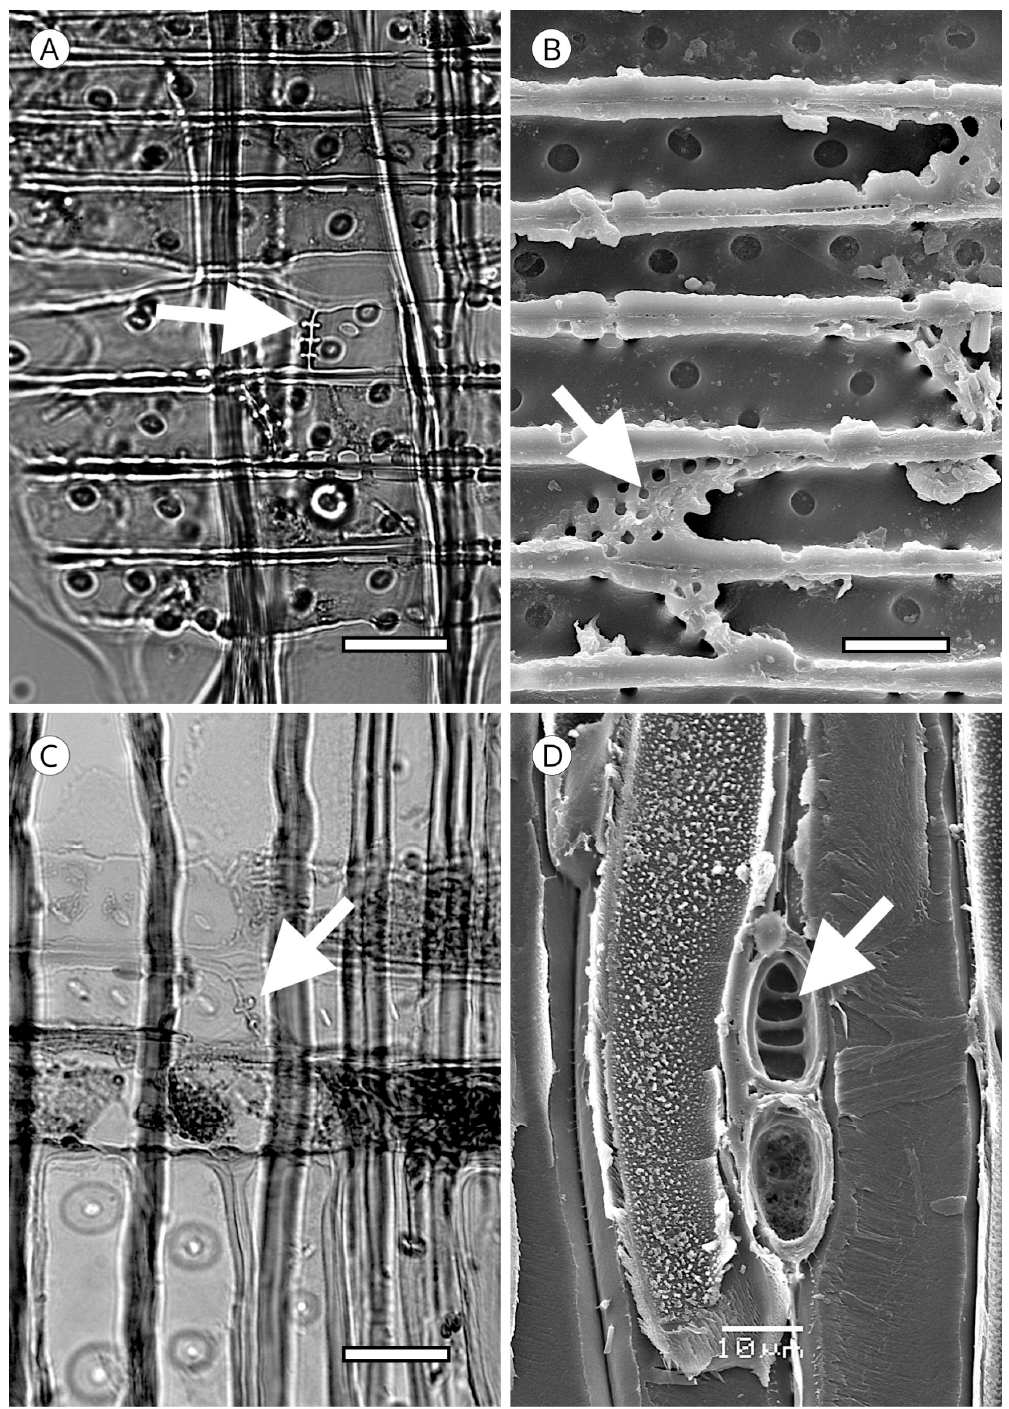
Figure 33. Nodular end walls of ray parenchyma cells. ( A ) Abies alba Mill.; ( B ) Abies cilicica (Antoine & Kotschy) Carrière (SEM); ( C ) Fitzroya cupressoides (Molina) I.M.Johnst.; ( D ) Juniperus californica Carrière (SEM). Scale bars. ( A – C ) = 25 μ m.